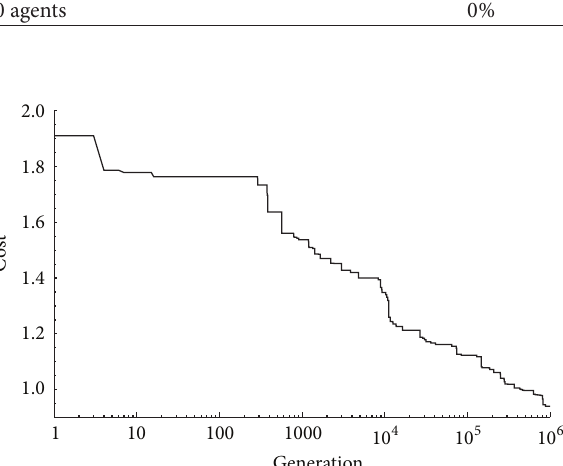
Figure 10: Convergence of the Team Plan cost for the 20-400 MAPP shown in Figure